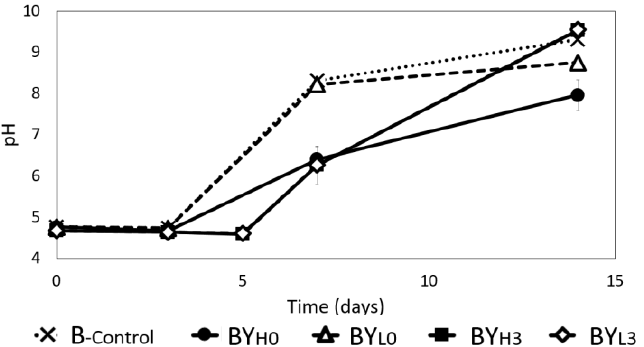
Figure 3. Changes in pH during 14 days of cultivation using K. intermedius mono- (B -control ) and co-cultures with D. bruxellensis at 30 ◦ C. D. bruxellensis was added simultaneously at concentrations of 10 6 CFU/mL (BY H0 ) and 10 3 CFU/mL (BY L0 ) and sequentially at 10 6 CFU/mL (BY H3 ) and 10 3 CFU/mL (BY L3